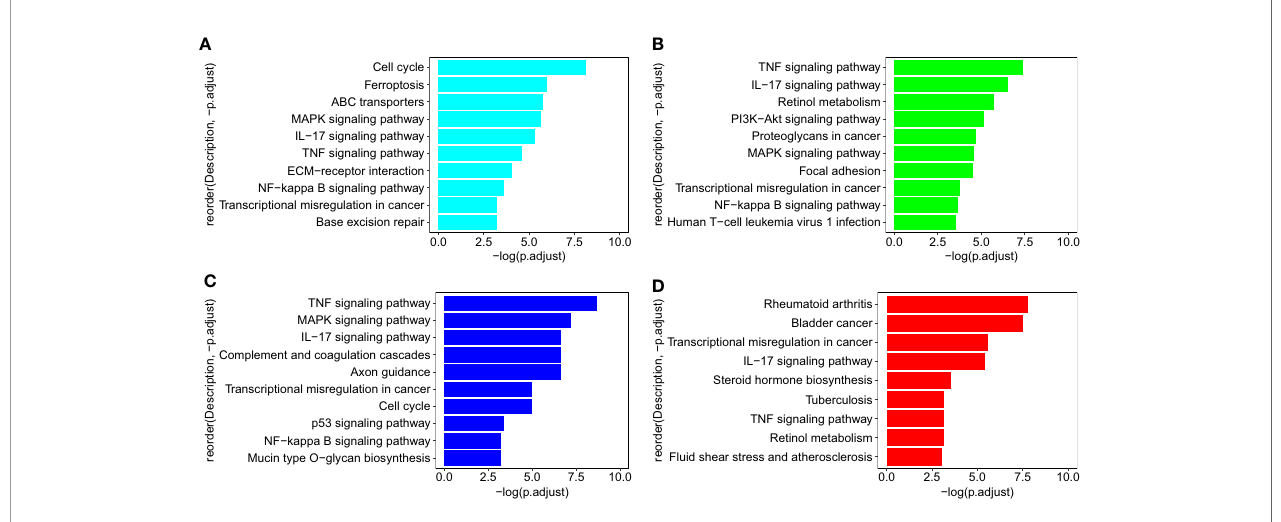
FIGURE 2 | KEGG pathways in three candidate drugs and group 3. (A – C) Three TCM ( R. communis L ., E . cochinchinensis Lour ., B . fruticosa ) which were enriched on all fi ve pathways: TNF signaling pathway, IL − 17 signaling pathway, NF-kappa B signaling pathway, Transcriptional misregulation in cancer, and MAPK signaling pathway; (D) group 3 includes three important pathways: IL − 17 signaling pathway and TNF signaling pathway participated in the pro-in fl ammatory process; Transcriptional misregulation in cancer is important for cancer metastasis